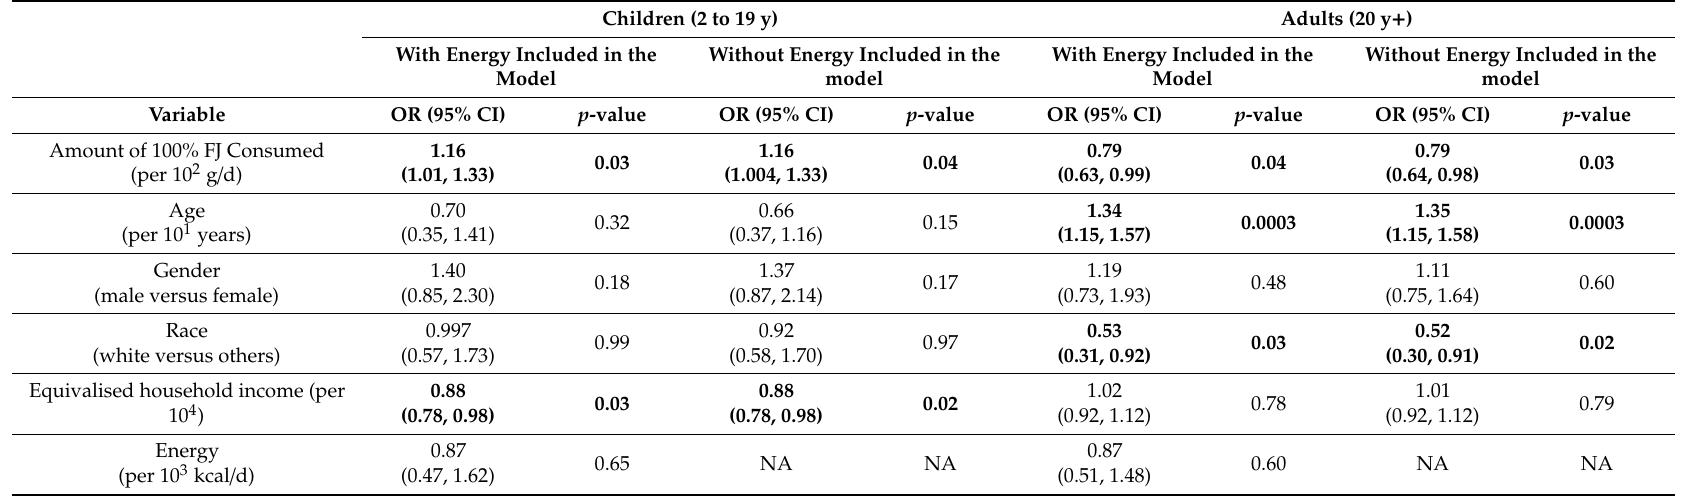
CI = confidence intervals; FJ = fruit juice; NA = not applicable; NDNS = National Diet and Nutrition Survey; OR = odds ratio; UK = United Kingdom; y = years; Bolded values were statistically